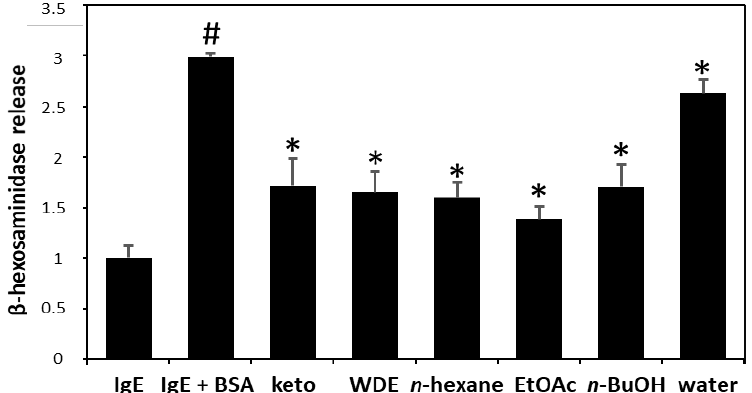
Figure 1. Anti-allergic effects of Wikstroemia dolichantha total extract (WDE) and fractions ( n -hexane, EtOAc, n -BuOH, and water fraction) on β -hexosaminidase release from IgE-mediated RBL-2H3 cells. Results are expressed as the means ± SDs of two independent experiments. # p < 0.05 vs. vehicle control; * p < 0.05 vs. IgE + DNP-BSA treated cells. IgE = vehicle control, IgE + BSA = IgE + DNP-BSA treated cells, keto = 30 μ M ketotifene.